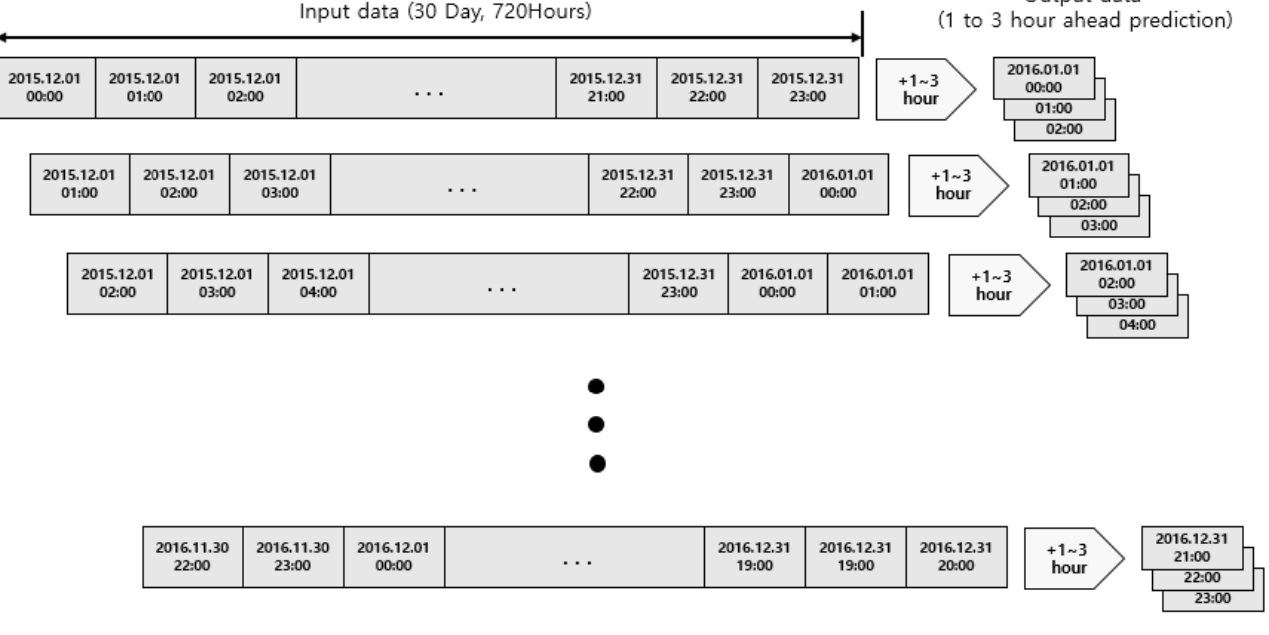
Figure 2. Data management for prediction 1 to 3 h in advance.